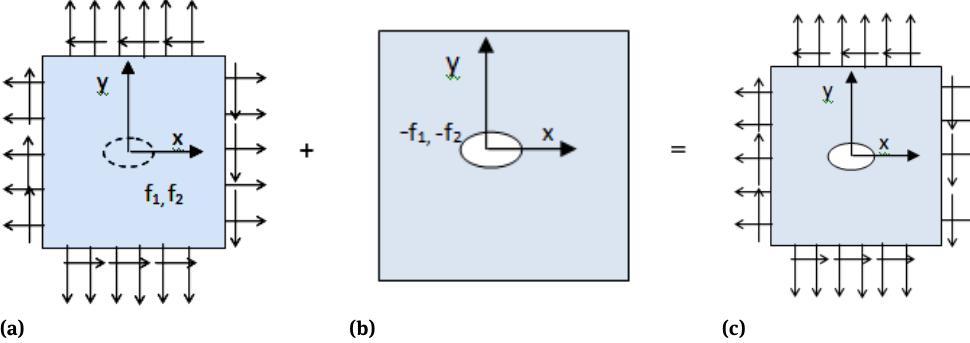
Figure 3: Solution scheme: a) Plate without hole & loading at infinity; b) Plate with negative of boundary condition at hole boundary; c) Plate with eliptical hole & loading at